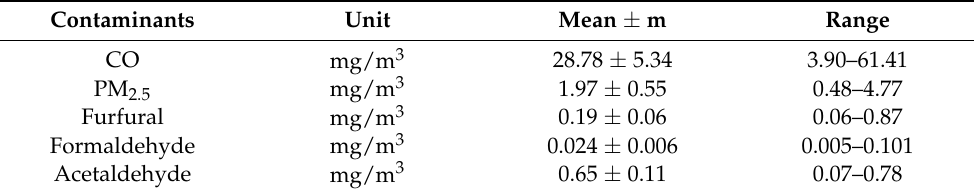
Table 1. Average concentration of PM 2.5 and select gaseous pollutants in exposure chamber.